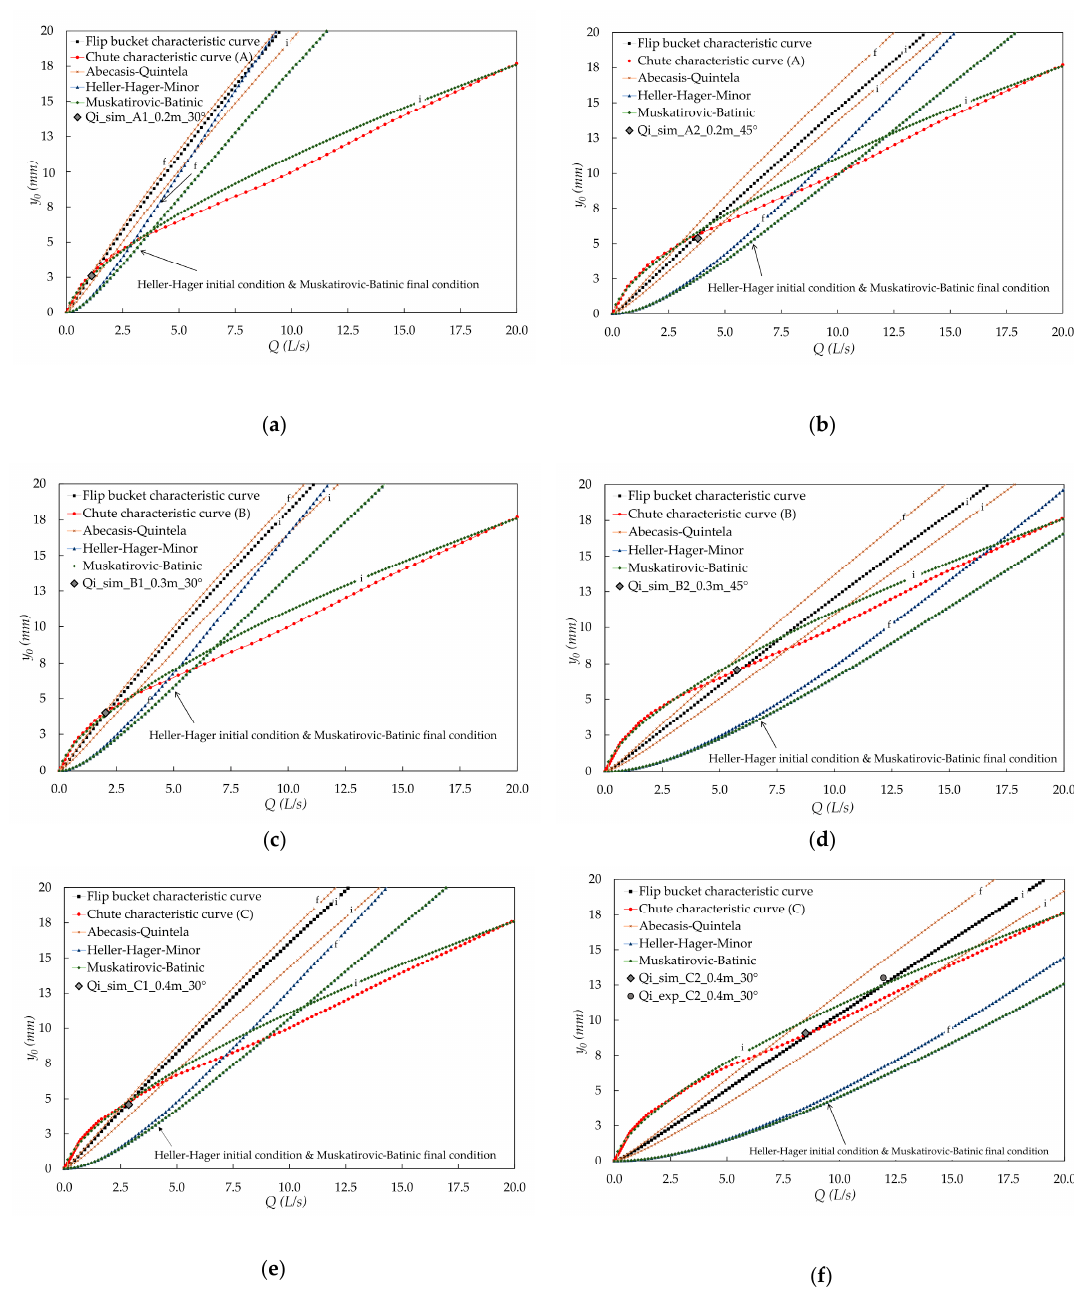
Figure 16. Comparison of the results obtained using the formulas of various authors. The flip bucket characteristic curve is represented according to the formula of different authors. For the previous formulas, it is indicated with “i” the initiation condition of the jet flow, and with “f” the end condition of the jet flow: ( a ) A1; ( b ) A2; ( c ) B1; ( d ) B2; ( e ) C1; ( f ) C2. Table 13. Flow rate for the initiation of the jet flow Qi and flow depth at the lowest point of the flip bucket y 0i obtained using the formula of different authors, by means of the proposed formula and by numerical simulation Absolute Error and Relative Error, taking as the reference the flow rate obtained with the numerical simulation Qi sim .